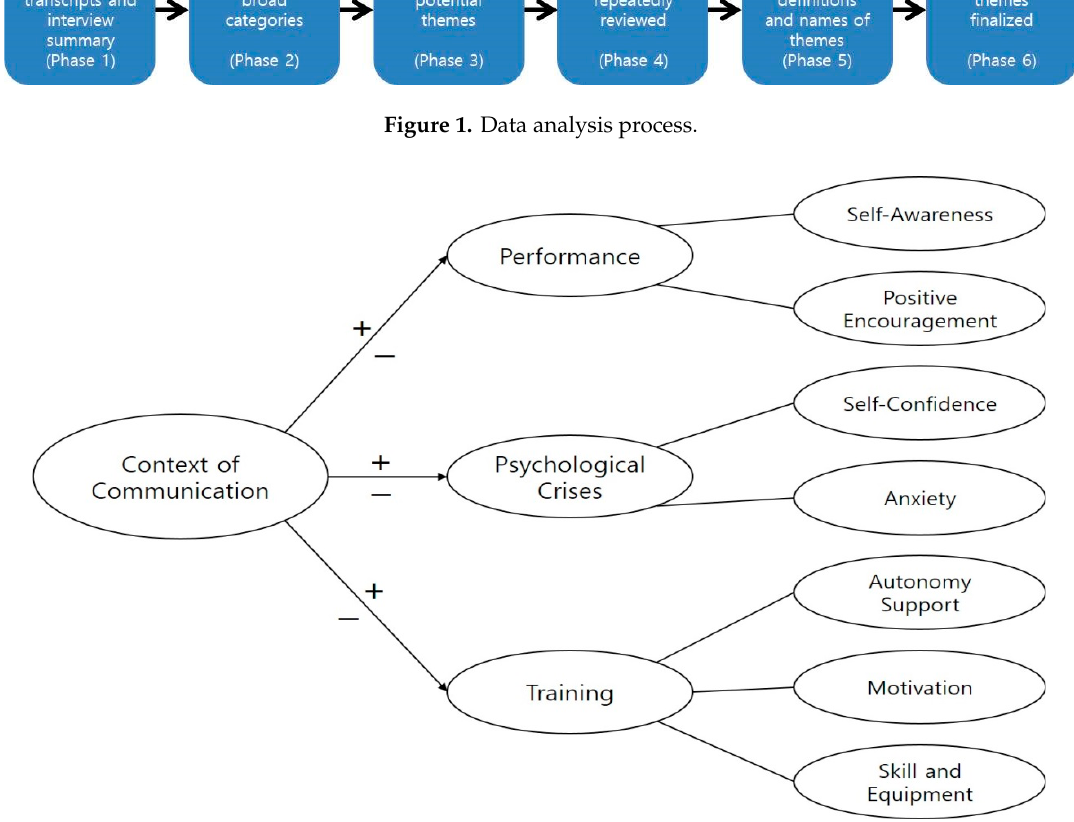
Figure 2. Conceptual map of the relationship between themes and subthemes.